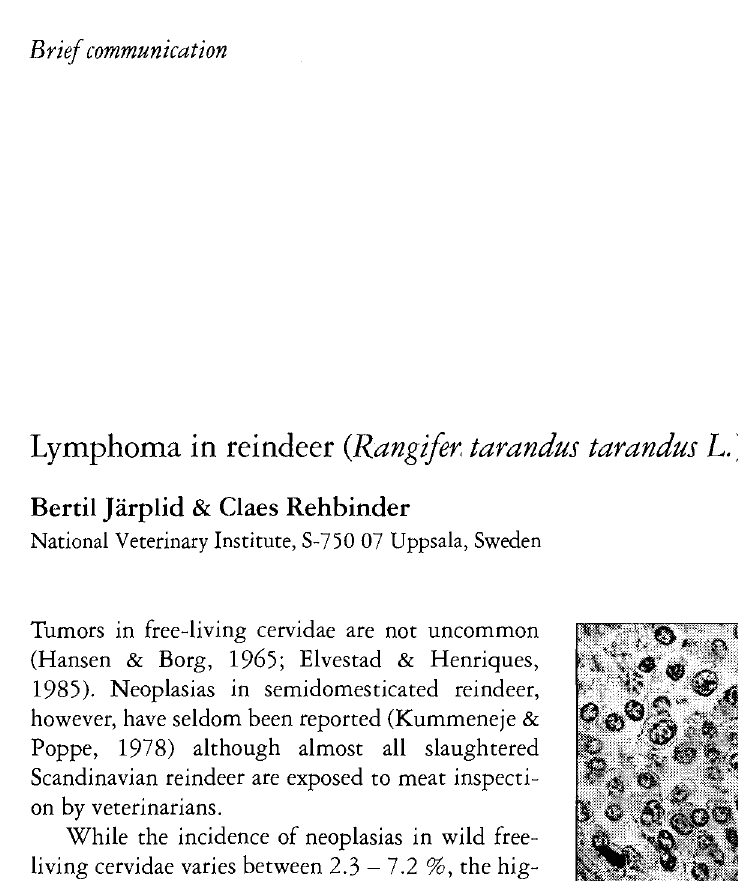
Fig. 1. Lymphoma in reindeer. Monomorphic cells with large cytoplasm. The morphology of this tumor resembles that of mantle zone lymphoma in bovi ne. HE x 670. Photo: C. Rehbinder.